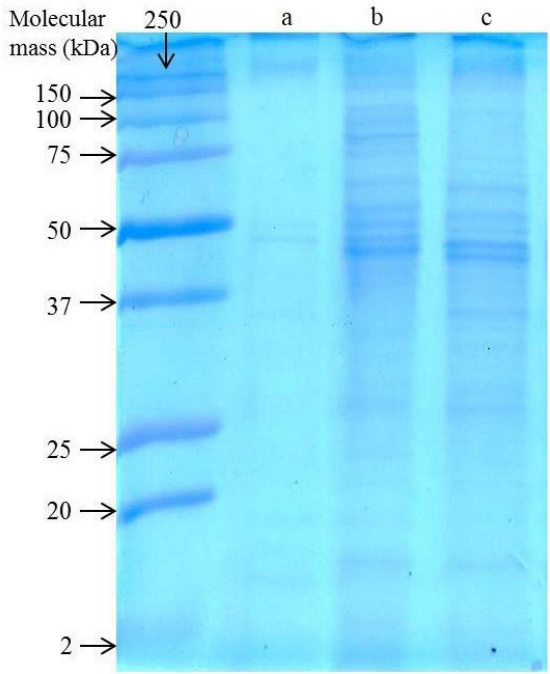
Figure 2. SDS / PAGE of whole cell lysates of the untreated 2De strain ( a ) in comparison to the strain cultivated with 0.5 M MnO 2 ( b ) or 4% soil from metallurgical waste heap ( c Figure 2. SDS/PAGE of whole cell lysates of the untreated 2De strain (a) in comparison to the strain 262 cultivated with 0.5 M MnO 2 (b) or 4% soil from metallurgical waste heap (c). 263